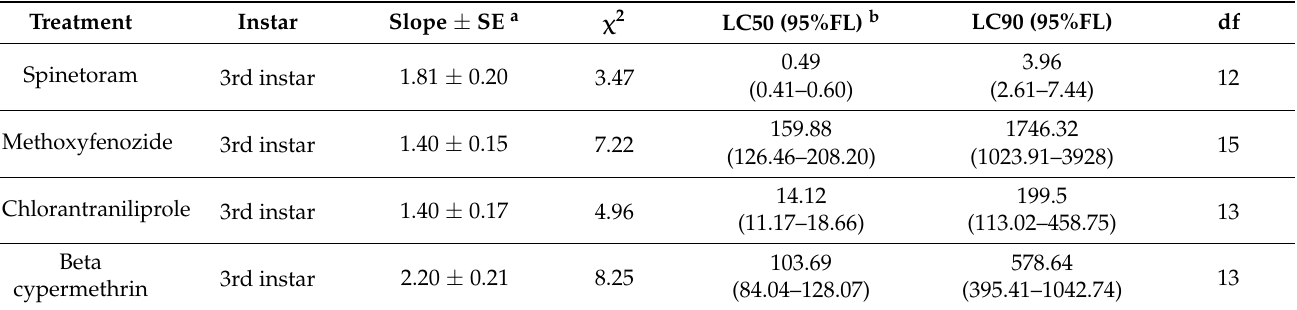
Table 2. Toxicity of 4 pesticides to 3rd instar larvae of S. frugiperda at 48 h.